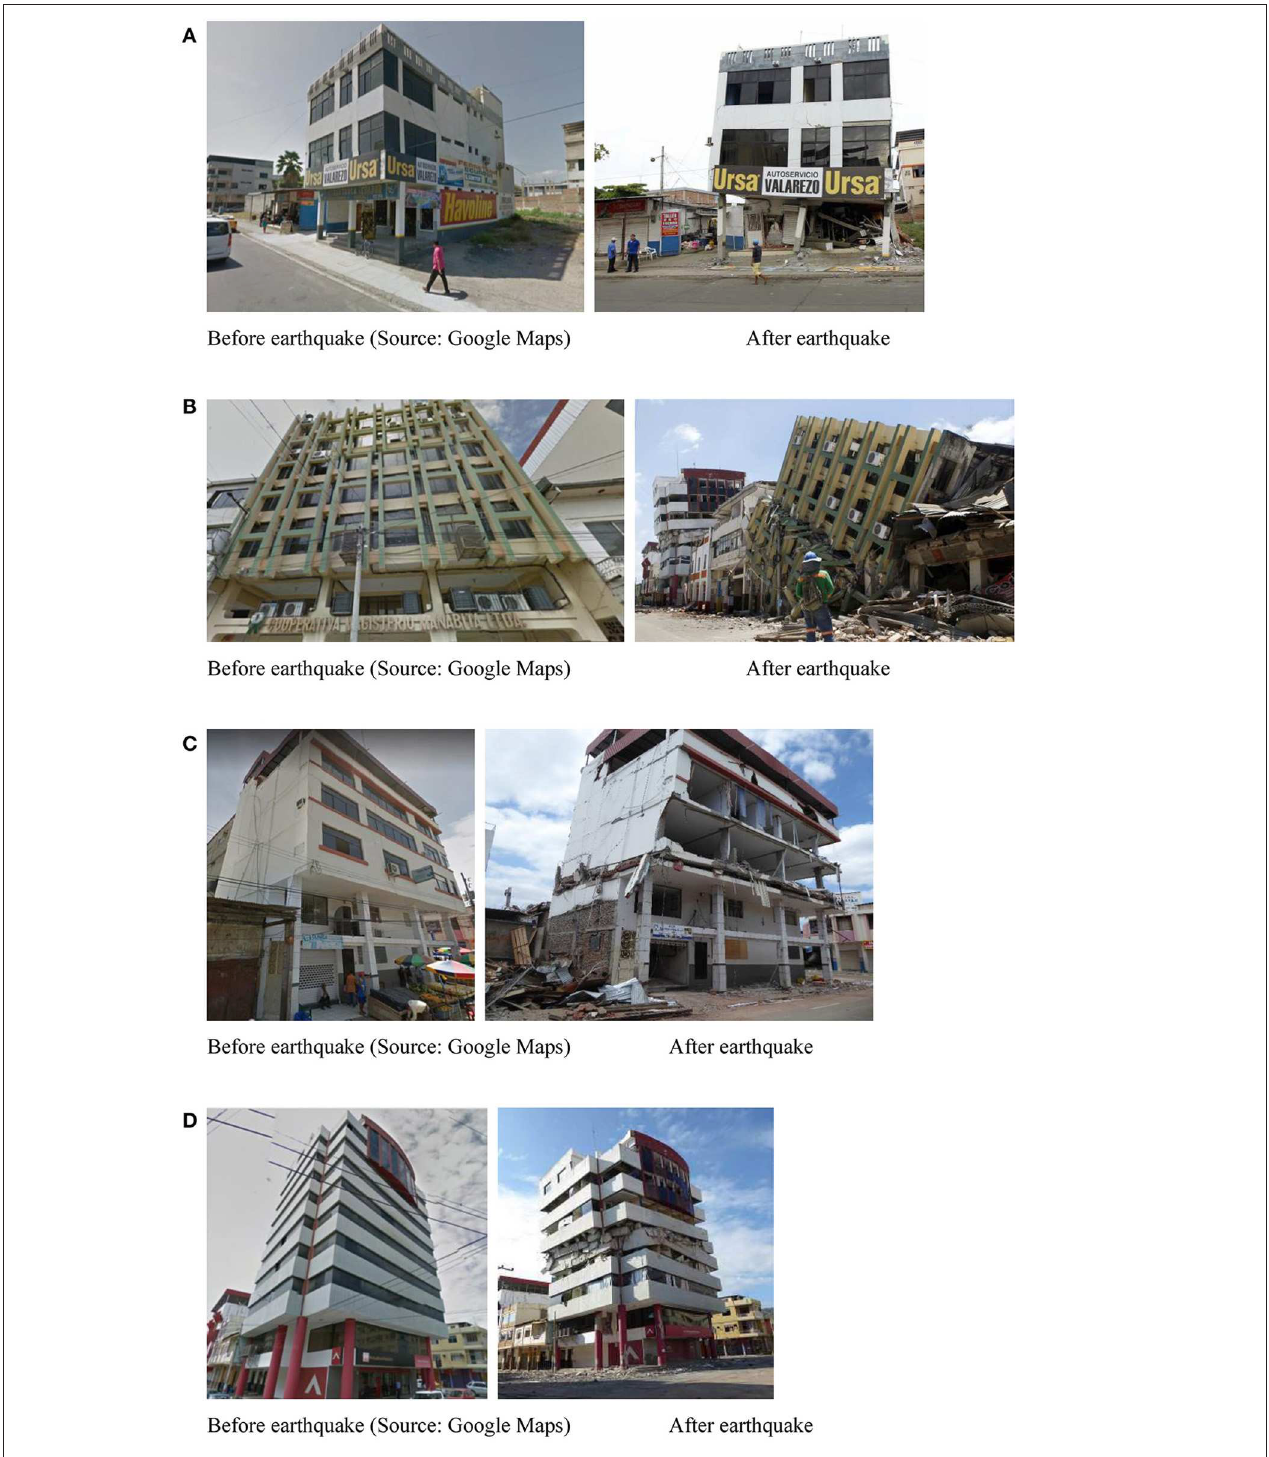
FIGURE 8 | Soft story collapse following the Muisne earthquakes. (A) soft story collapse at groung level of car garage at Manta. (B) Upper story collapse at the Magistrate building at Potoviejo due to change in stiffness at 1st floor. (C) Upper story collapse at commercial building at Manta due to change in stiffness at 2nd floor. (D) Upper story collapse at Mutualista Pichincha building in